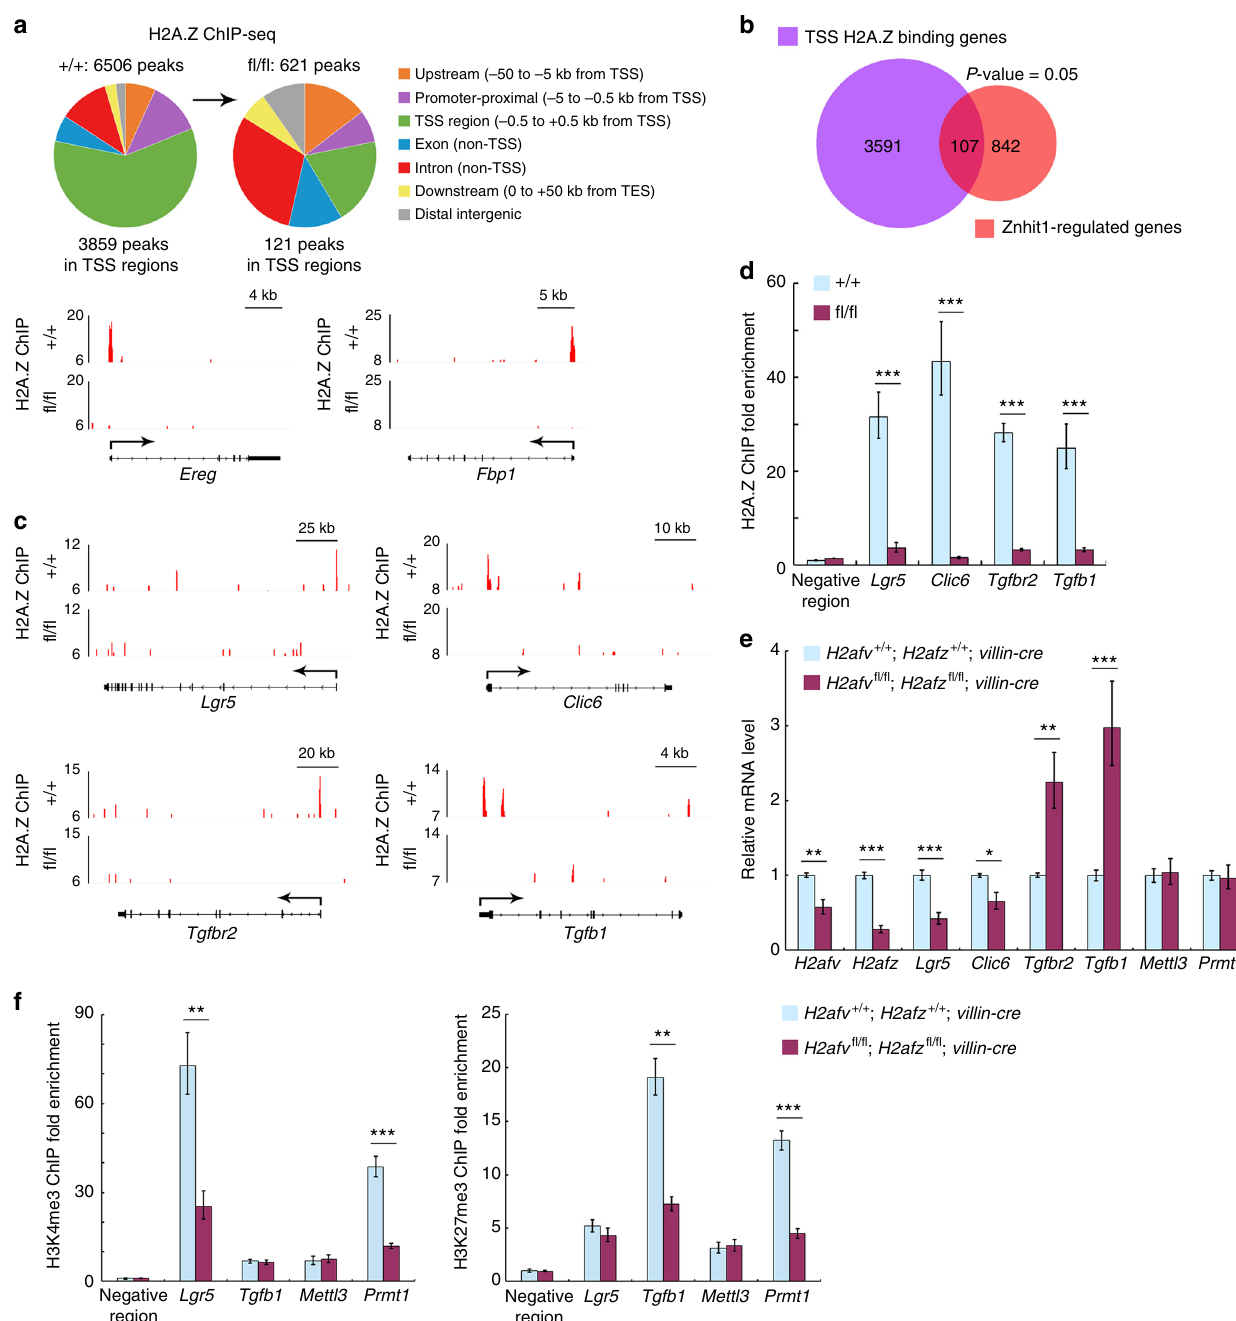
Fig. 4 Znhit1 incorporates H2A.Z for transcriptional regulation. a Distribution of H2A.Z on genome of intestinal crypts. Eight-week-old Villin-creERT ( + / + ) and Znhit1 fl / fl ; Villin-creERT ( fl / fl ) mice were daily injected with tamoxifen for 3 days followed by 5-day waiting period. Intestinal crypts were harvested for ChIP-seq. ChIP-seq signals for H2A.Z binding at Ereg and Fbp1 loci were shown as examples. b Venn diagram showing the overlap between TSS H2A.Z binding genes and Znhit1-regulated genes. The signi fi cance was evaluated by Fisher ’ s exact test. c ChIP-seq signals for H2A.Z binding at Lgr5 , Clic6 , Tgfbr2 , and Tgfb1 loci. d Eight-week-old Villin-creERT ( + / + ) and Znhit1 fl / fl ; Villin-creERT ( fl / fl ) mice were daily injected with tamoxifen for 3 days followed by 5-day waiting period. Intestinal crypts were harvested and ChIP-qPCR was performed to examine the fold enrichment of H2A.Z in TSS region of indicated genes. e Intestinal crypts were harvested from H2afv + / + ; H2afz + / + ; Villin-cre and H2afv fl / fl ; H2afz fl / fl ; Villin-cre mice at P9 to examine the expression of indicated genes using qRT-PCR. Histone H3 was used as an internal control. f Intestinal crypts were harvested from H2afv + / + ; H2afz + / + ; Villin-cre and H2afv fl / fl ; H2afz fl / fl ; Villin-cre mice at P9 and ChIP-qPCR was performed to examine the fold enrichment of H3K4me3 and H3K27me3 in TSS region of indicated genes. The statistical data represent mean ± s.d. ( n = 3 mice per genotype). Student ’ s t -test: *** P < 0.001. ** P < 0.01. * P <